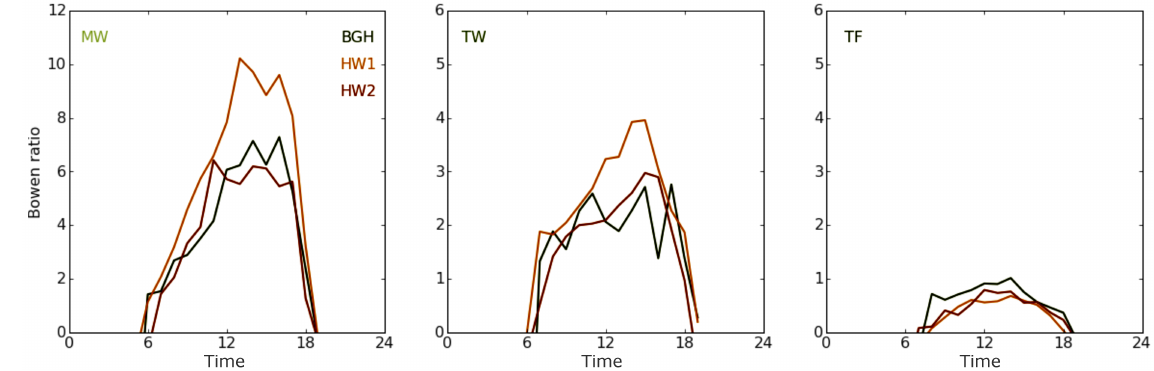
Figure 6. Average daytime Bowen ratio measured over Mediterranean woodlands (MW, left panel), the temperate woodlands (TW, middle panel) and the temperate forest (TF, right panel) for BGH (green line), HW1 (light amber) and HW2 (dark